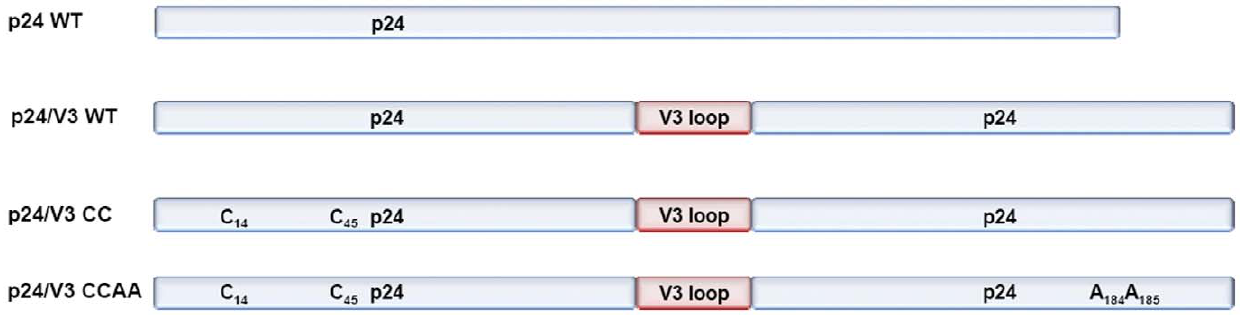
Figure 2. Amino acid sequence of the p24:V3 chimeras. The amino acid sequence of wild type and mutant p24:V3 chimera are indicated. Mutated residues in CC and CCAA mutants are underlined. The V3 loop sequence inserted in the p24 sequence is indicated in the box.